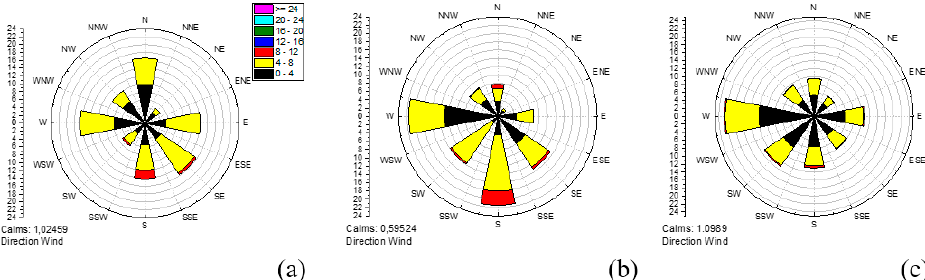
Figure 7. Wind roses for the October–December ( a ) 2016, ( b ) 2017 and ( c ) 2016 December–2017 October.